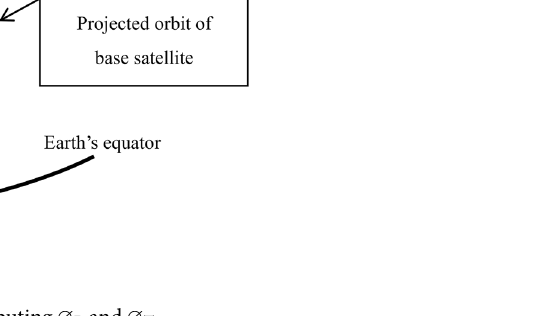
Figure 4. Spherical triangle for computing ∅ B and ∅ T